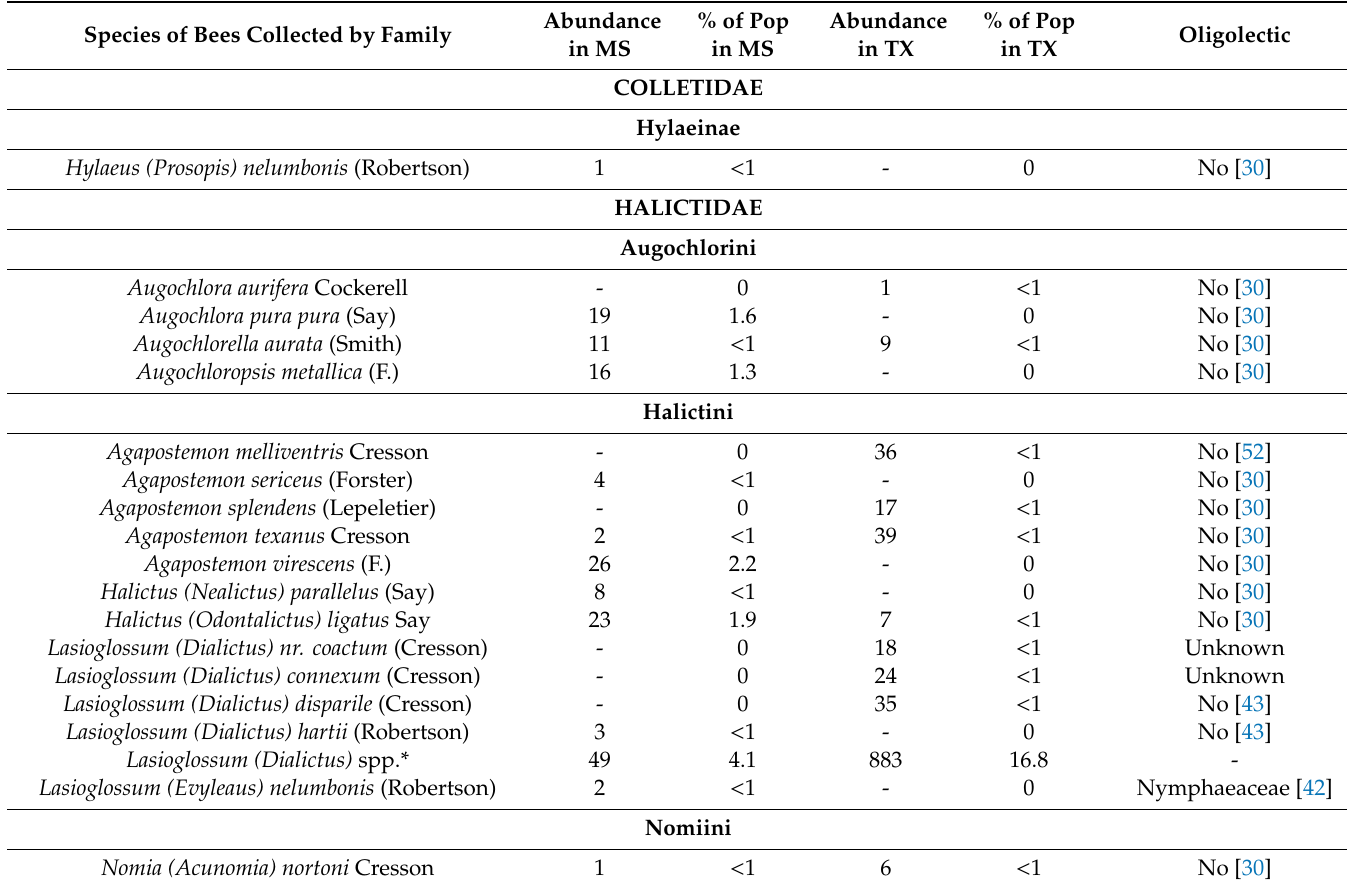
Table 1. Native bees (Hymenoptera: Anthophila) collected in cotton fields in several locations in both Mississippi and Texas. Sampling e ff orts and times varied among years and